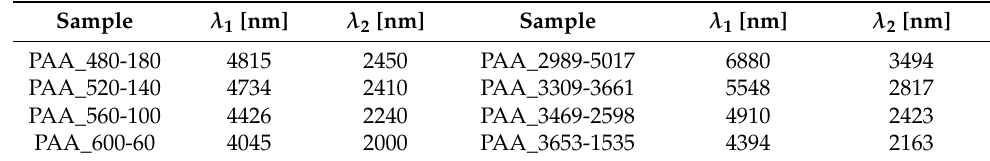
Table 2. The spectral position of the λ 1 and λ 2 bands calculated using EPITAXYproject ® software and assuming the same refractive indices ( n H = 1.43 and n L = 1.52) for all samples. Sample λ 1 [nm] λ 2 [nm] Sample λ 1 [nm]